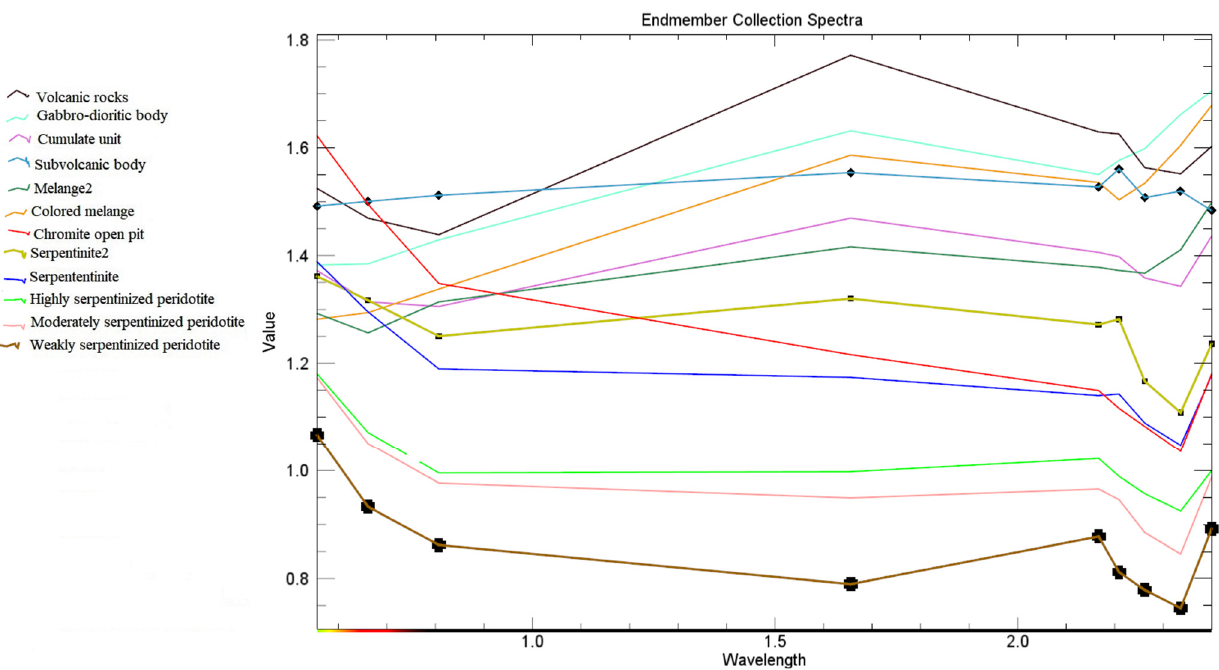
Figure 10. Reflectance spectra of the identified lithological units including serpentinized peridotites with different severity of serpentinization. The dots on some curves show the location of ASTER bands.